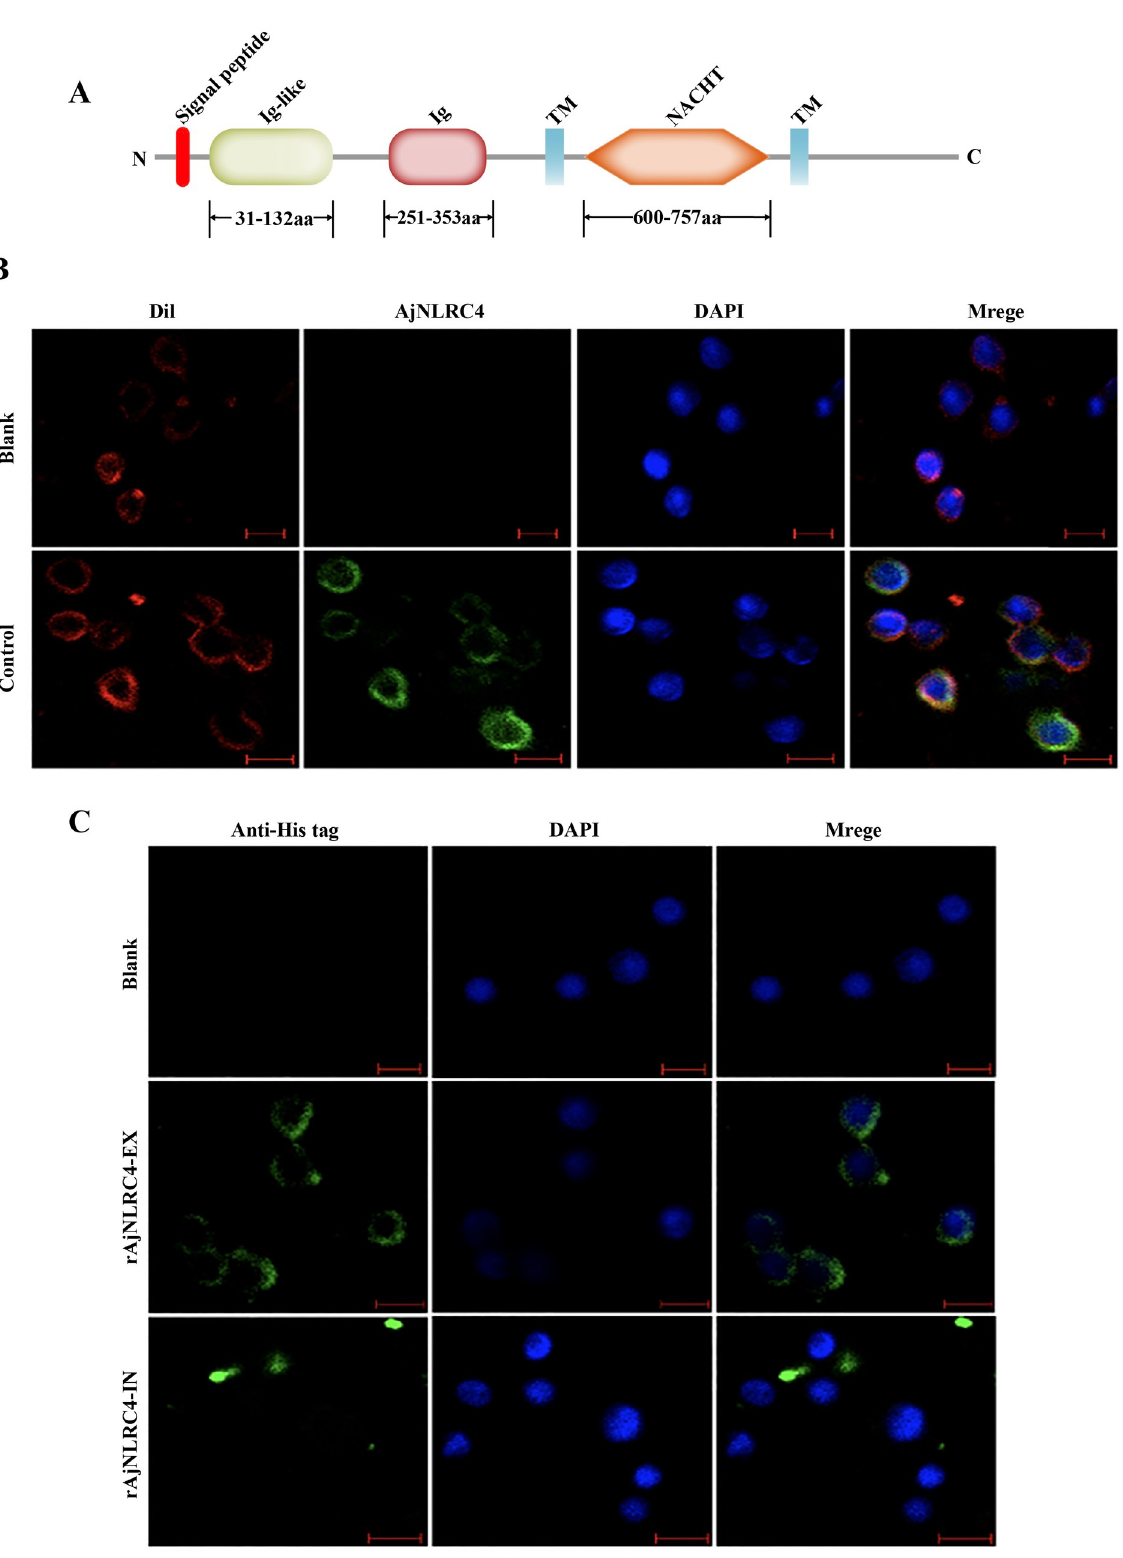
Fig 1. AjNLRC4 is located in the membrane of sea cucumber coelomocytes. (A) The domain architecture of sea cucumber AjNLRC4 predicted by SMART (http://www.smart.embl-heidelberg.de/). (B) Analysis of AjNLRC4 subcellular distribution in sea cucumber